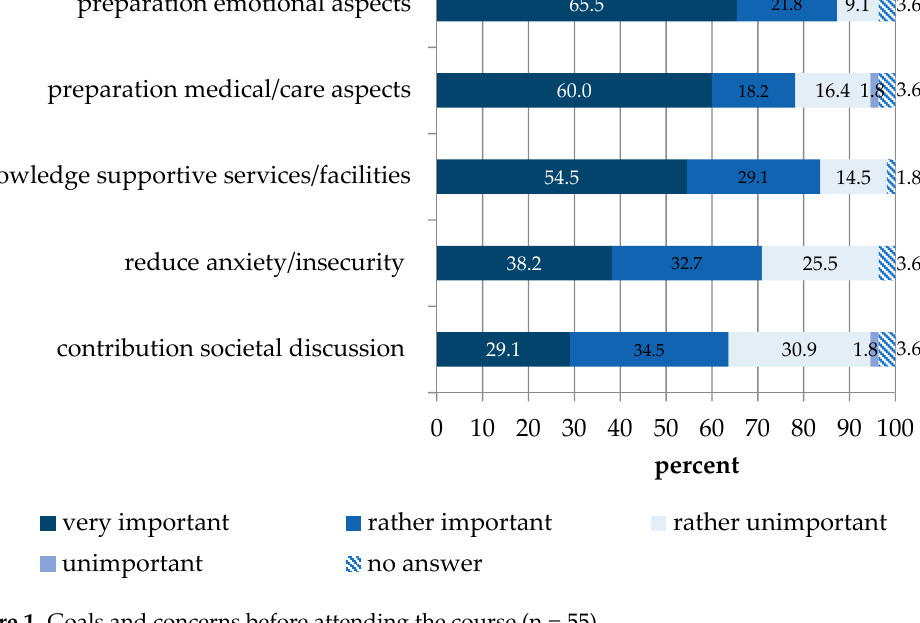
Figure 1. Goals and concerns before attending the course (n = 55).